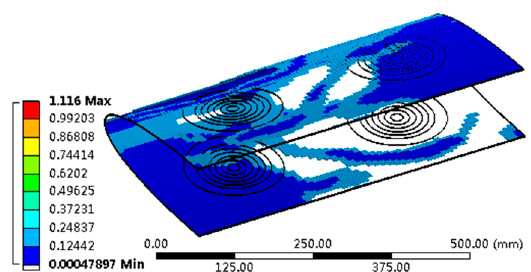
Figure 17. 1, 4 or 2, 3 of four coils are used (Mode 3).